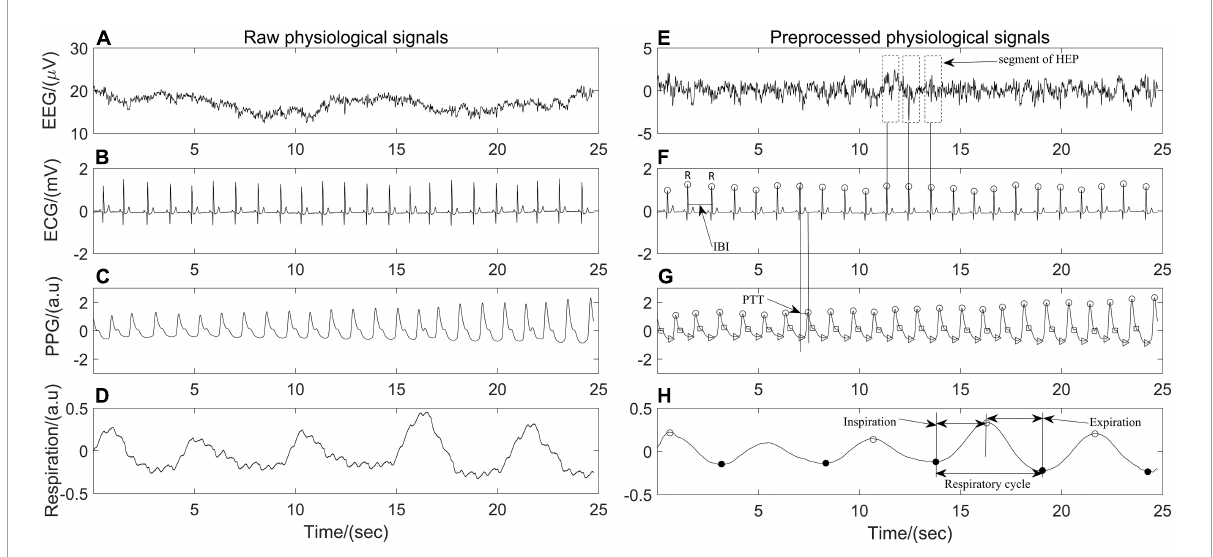
FIGURE1 Twenty-five seconds of synchronous (A–D) raw electroencephalography (EEG), electrocardiography (ECG), photoplethysmography (PPG), respiration signals and (E–H) their corresponding preprocessed signals of one participant in the position of supine.